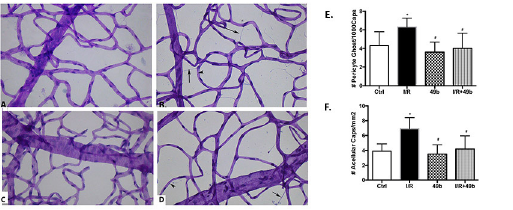
Fig 2. I/R produced significant vascular damage that were reduced following Compound 49b treatment. Panel A represents the control (left eye). Panel C represents eyes treated with 1mM Compound 49b only. Panels B, D are eyes exposed to ischemia/reperfusion (B) or I/R+Compound 49b (D). Panel E provides a graphical demonstration of the mean ± SEM for pericyte ghosts in each group. Panel F provides a graph for the numbers degenerate capillaries. Arrows represent degenerate capillaries and arrowheads are pericyte ghosts. Data is mean ± SEM. N = 4 for each group. * P < 0.05 vs. control; # P < 0.05 vs. I/R only without Compound